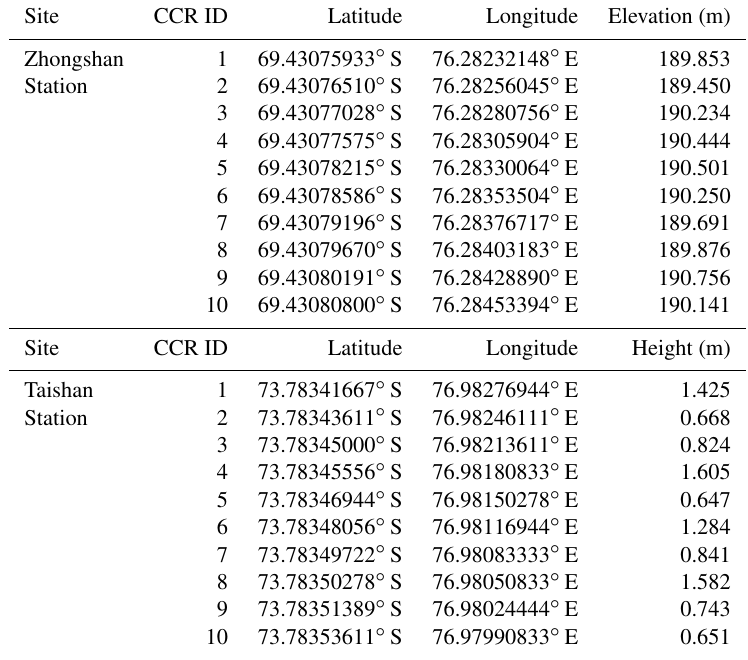
Table C1. Elevations of CCRs near Zhongshan Station were measured by a GNSS survey at centimeter-level accuracy. Heights of CCRs near Taishan Station were estimated from the CCR center offset parameter and distance measured from pole top to ice